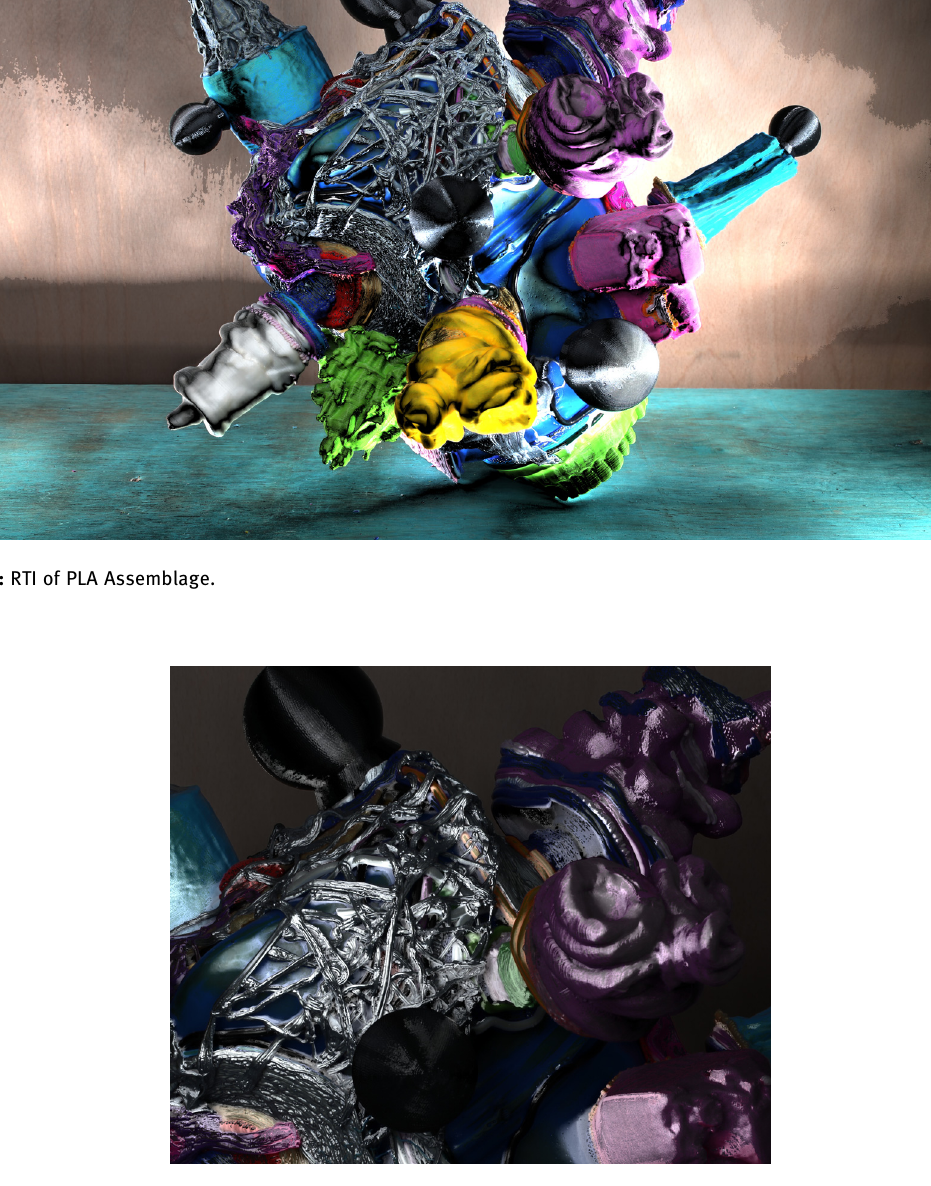
Figure 12: Detail of PLA Assemblage